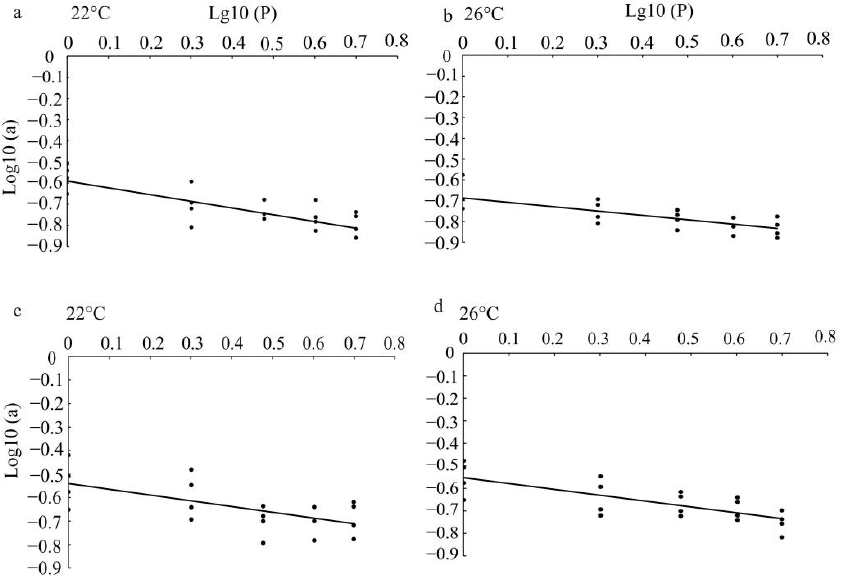
Figure 2. Regression lines of competition for Pa. hyposidrae and P. immunis . ( a ) and ( b ) represent interference relationship for Pa. hyposidrae at 22 ◦ C and 26 ◦ C, respectively. ( c ) and ( d ) represent interference relationship for P. immunis at 22 ◦ C and 26 ◦ C, respectively. Points represent the observed values. Lines show the predicted